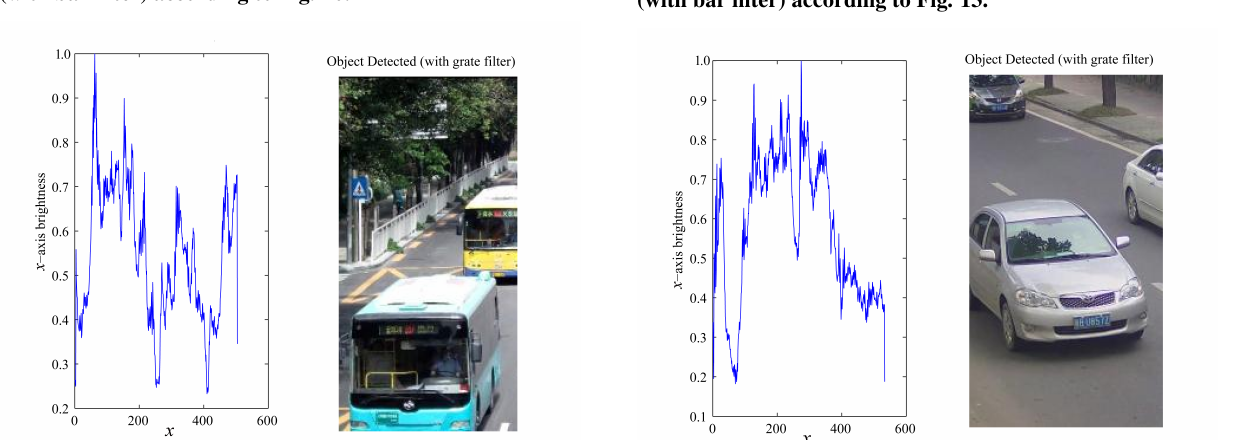
Fig. 11 Horizontal axis’ brightness values and selected bus (with bar filter) according to Fig. 10.